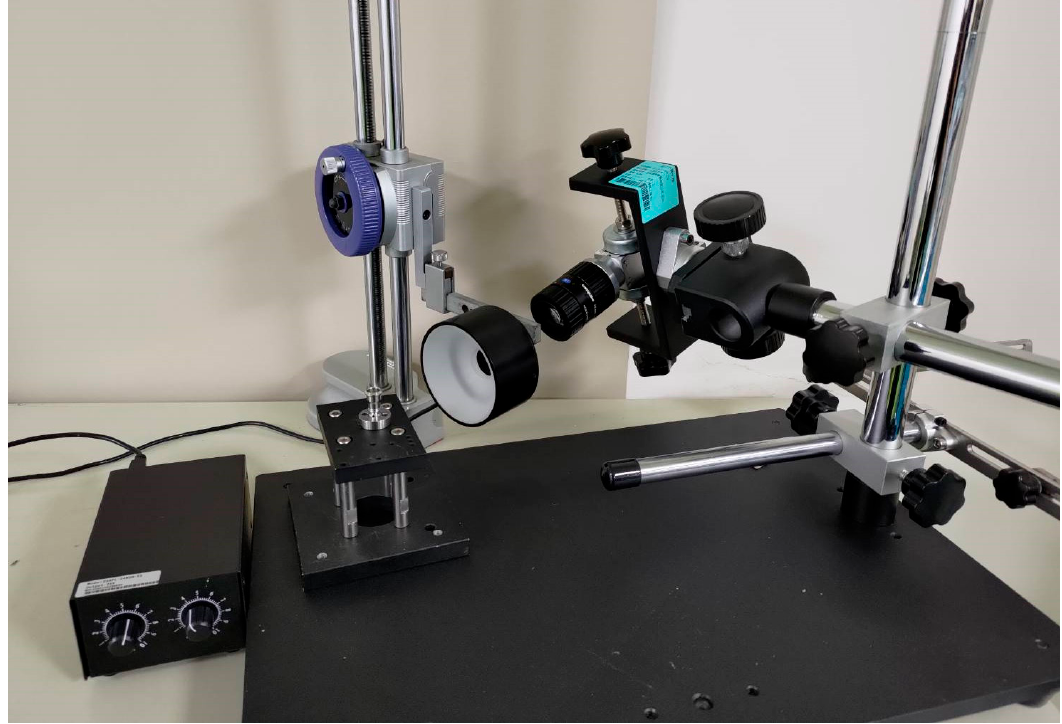
Figure 9. Illustration of the camera and light source positioning.